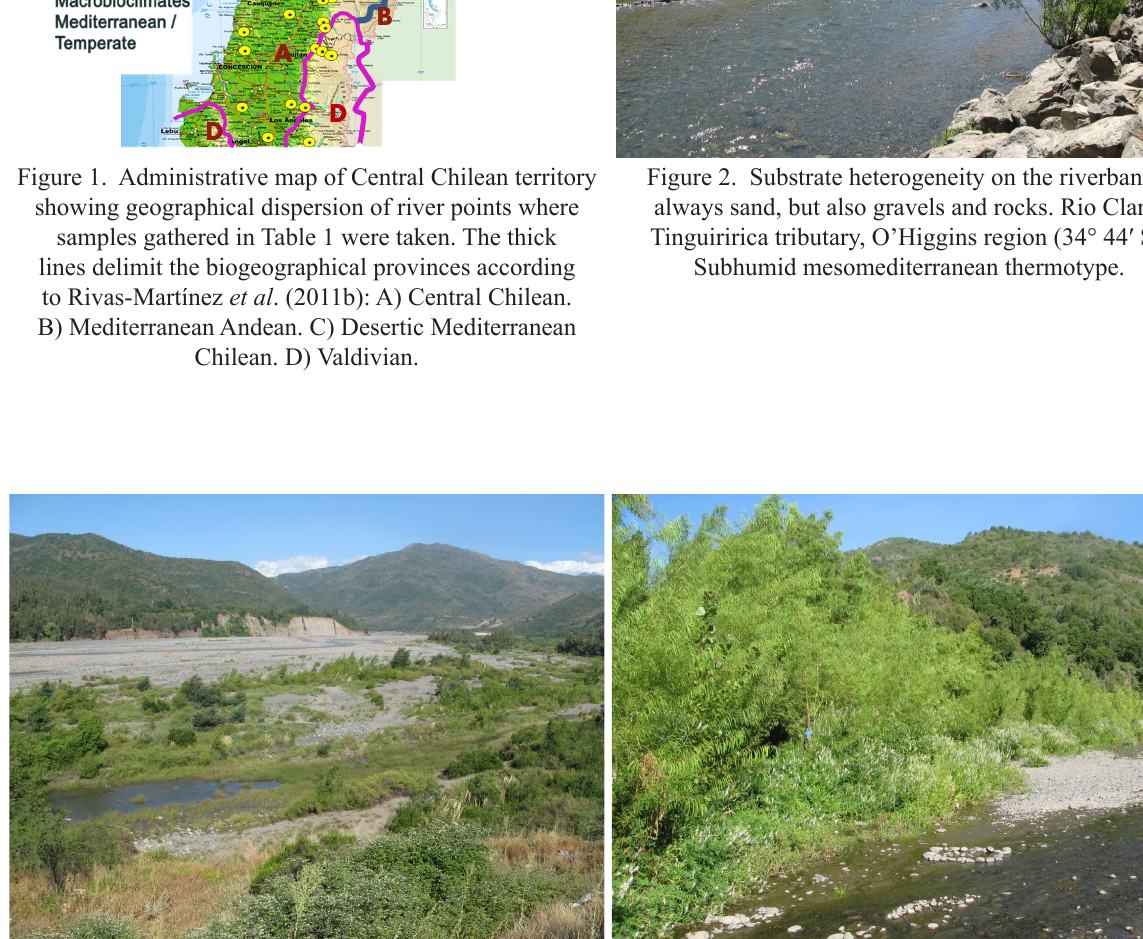
Figure 3. Typical landscape of a river in a broad valley Figure 4. Dense willow stand of Salix humboldtiana with riverbank vegetation linked to smaller streams prone in a narrow valley. The abundance of the allochthonous to dry out; the willow stand can be seen to be separate herb Galega officinalis is significant. Rio Claro, from the other phreatophilic scrublands. River Cachapoal, Pangal tributary, O’Higgins region (34° 16′ S). O’Higgins region (34° 22′ S). Dry mesomediterranean